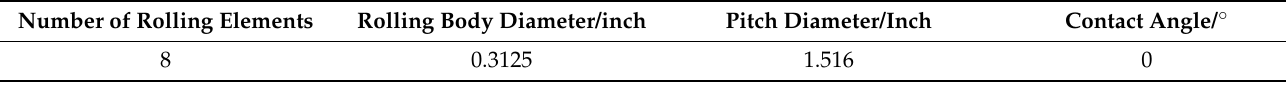
Table 2. Structural parameters of the ER-16K bearing.